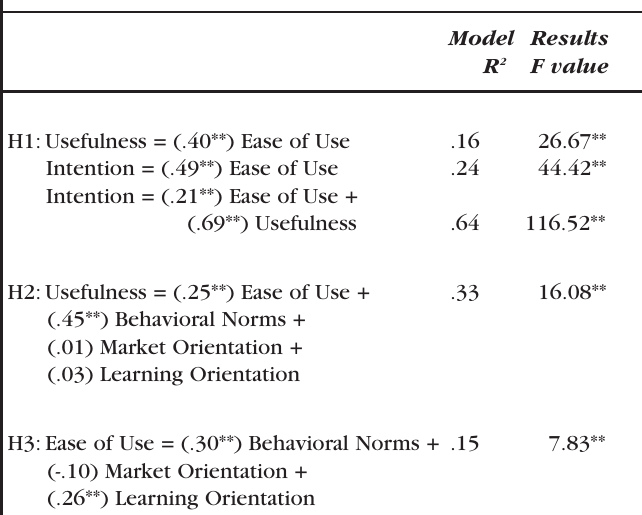
Table 2. Regression Analyses Testing